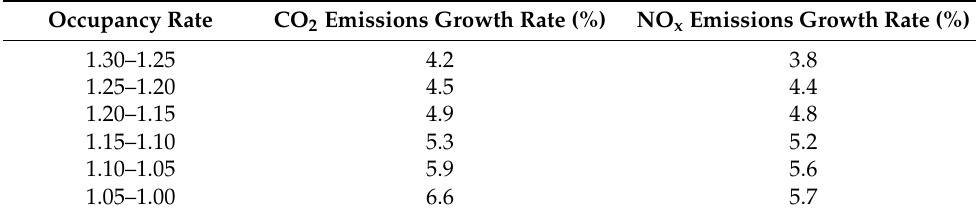
Table 3. CO 2 and NO x emissions growth rate for scenario (2).